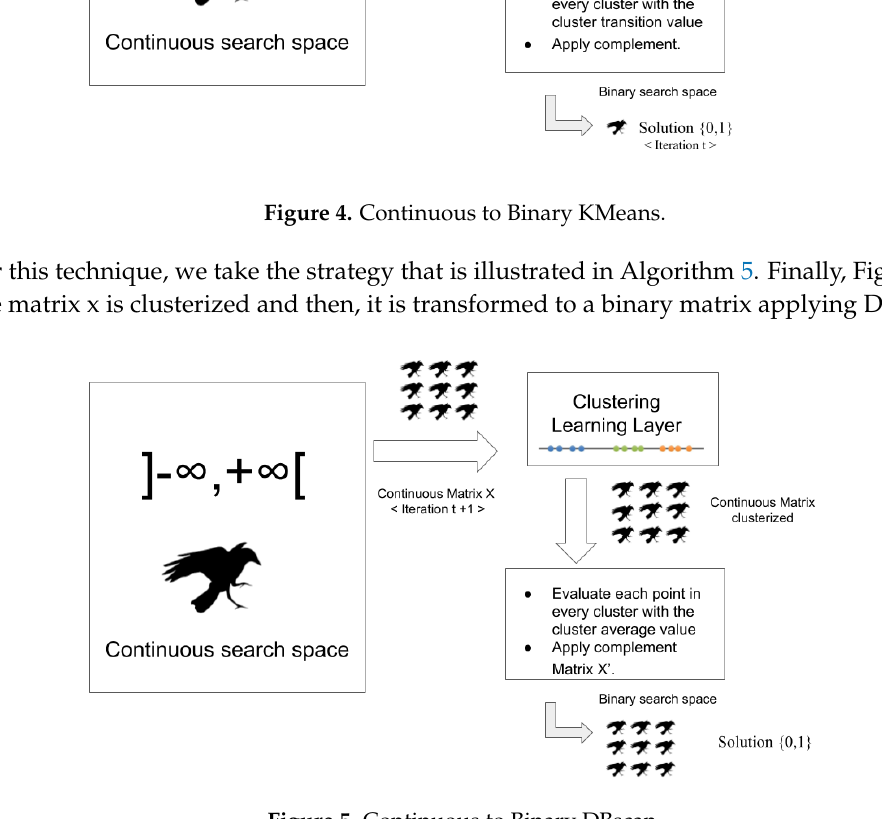
Figure 5. Continuous to Binary